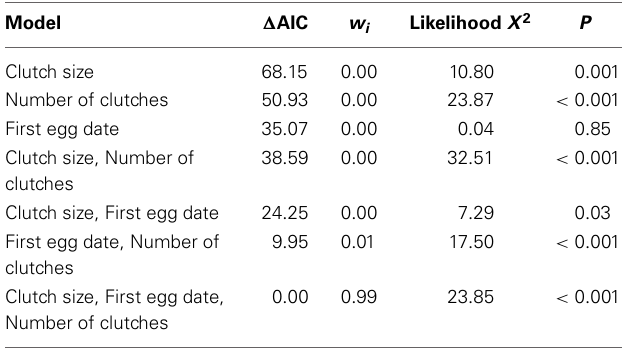
Table 3 | Model selection of the nest-specific significant variables that influence reproductive success.